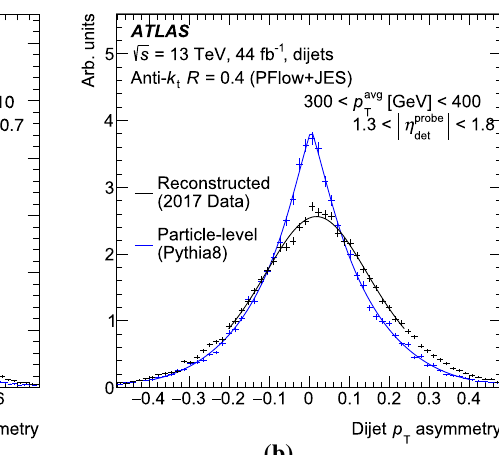
< 400 GeV in the range 1 . 3 < | η probe Fig. 25 Asymmetry distribution measured in data and particle-level 300 GeV < p avg T η ranges. Error bars Pythia 8 for PFlow jets in two example p In this η probe range the distributions can be asymmetric. Two fits are T and det represent the statistical uncertainty. a The measured asymmetry is performed iteratively: the particle-level asymmetry is modelled with < 110 GeV in the range shown for probe jets with 80 GeV < p avg an ad hoc function which is subsequently convolved with a Gaussian T | < 0 . 7, where the distributions are symmetric by con- function in order to describe the reconstructed asymmetry. The detector 0 . 2 < | η probe det resolution is then extracted from the Gaussian fit parameter struction. b The measured asymmetry is shown for probe jets with